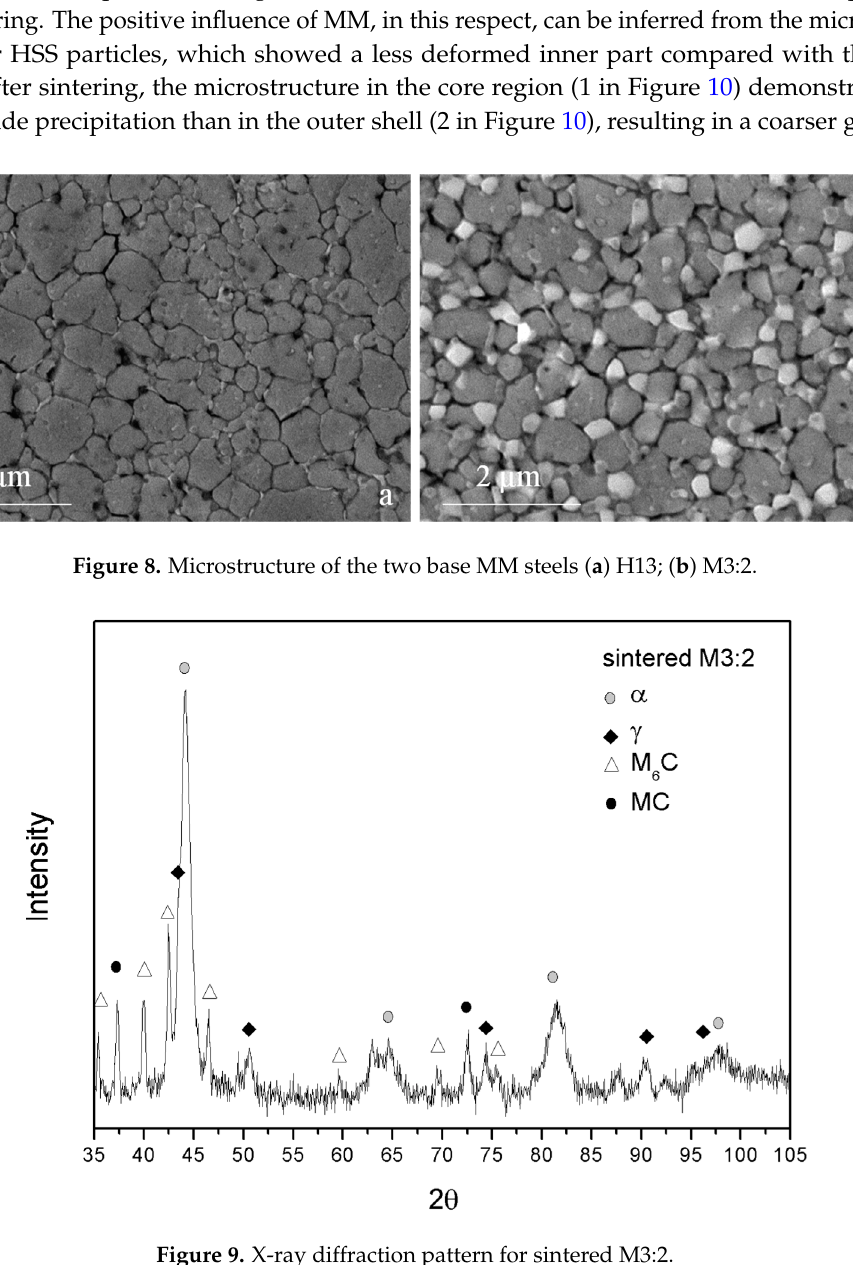
Figure 10. Microstructure of the hybrid tool steel showing the H13 and M3:2 regions. Please note the different grain sizes and carbide distributions in the outer (2) and inner (1) M3:2 particle regions due to the different extent of plastic deformation after milling (see also Figure 3d). In co-sintered steels, this is reflected in a further interesting result, which is the refinement of the grain size of the H13 neighbouring the HSS particle, i.e. , showing the smallest grain size. In other words, the grain growth in H13 is constrained by the grain boundaries of M3:2.